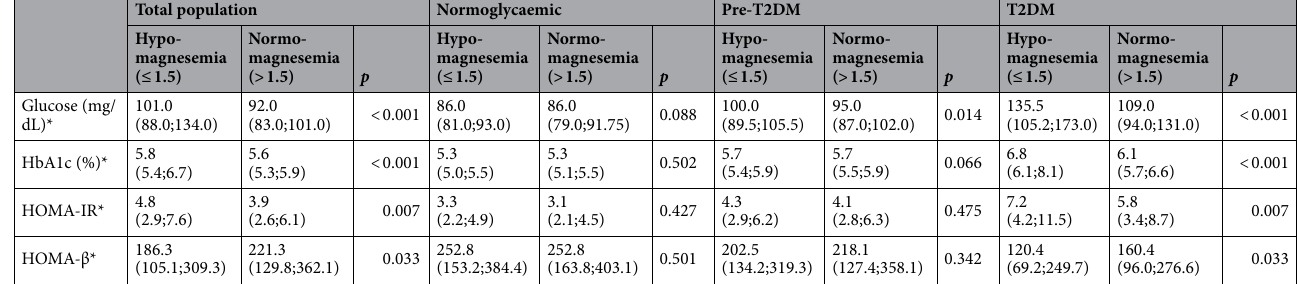
Table 2. Correlations between magnesium levels and glycaemic indicators according to the glycaemic profile. *Median (P25, P75).